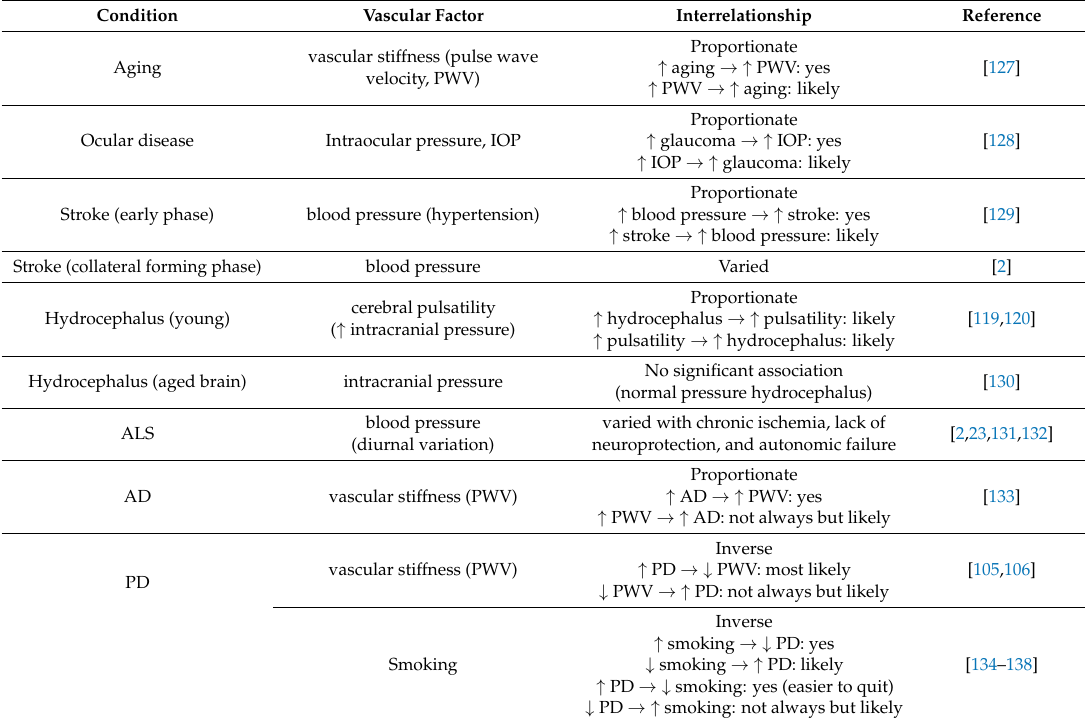
Table 4. A relationship between vascular risk factors and neurological